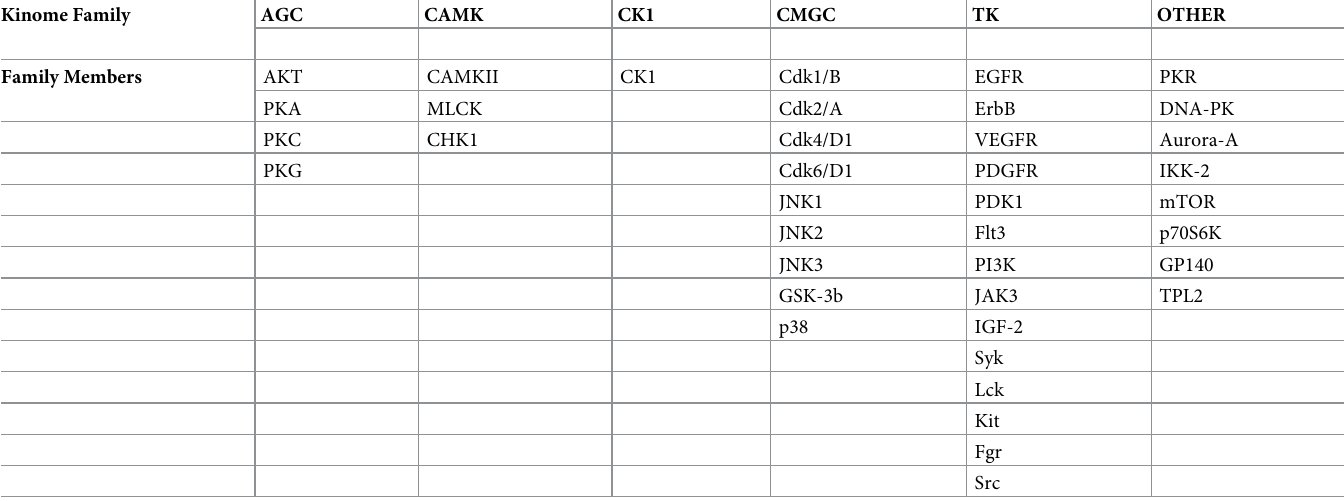
Table 1. Targets of kinase inhibitor hits in this